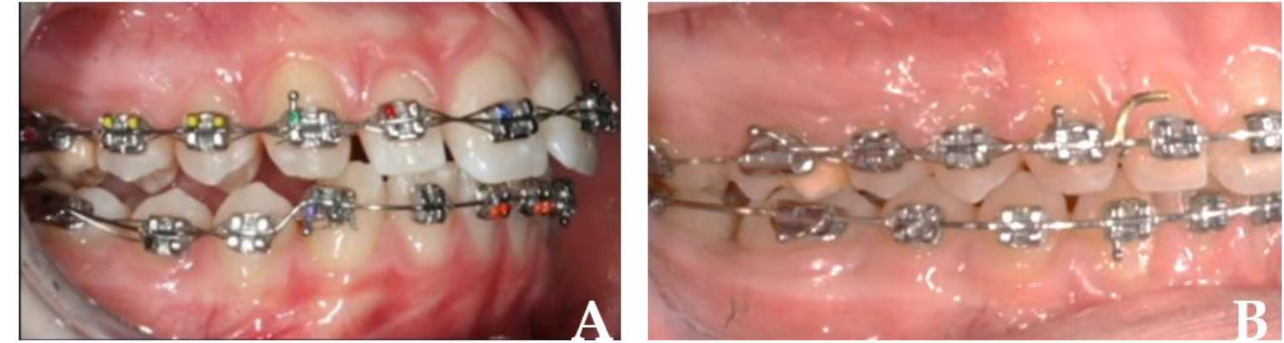
Figure 3. Multibracket appliance during curve of Spee leveling: ( A ) at the beginning of the treatment; ( B ) at the end of the